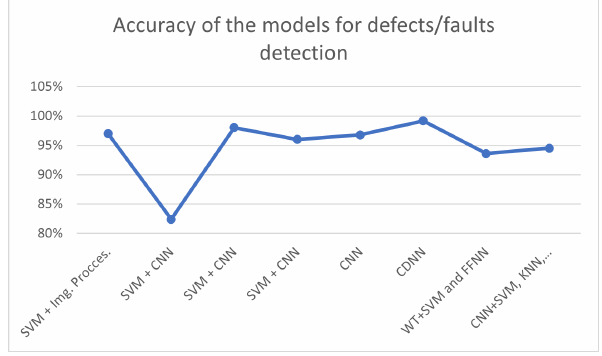
Figure 10. Accuracy of the different models for